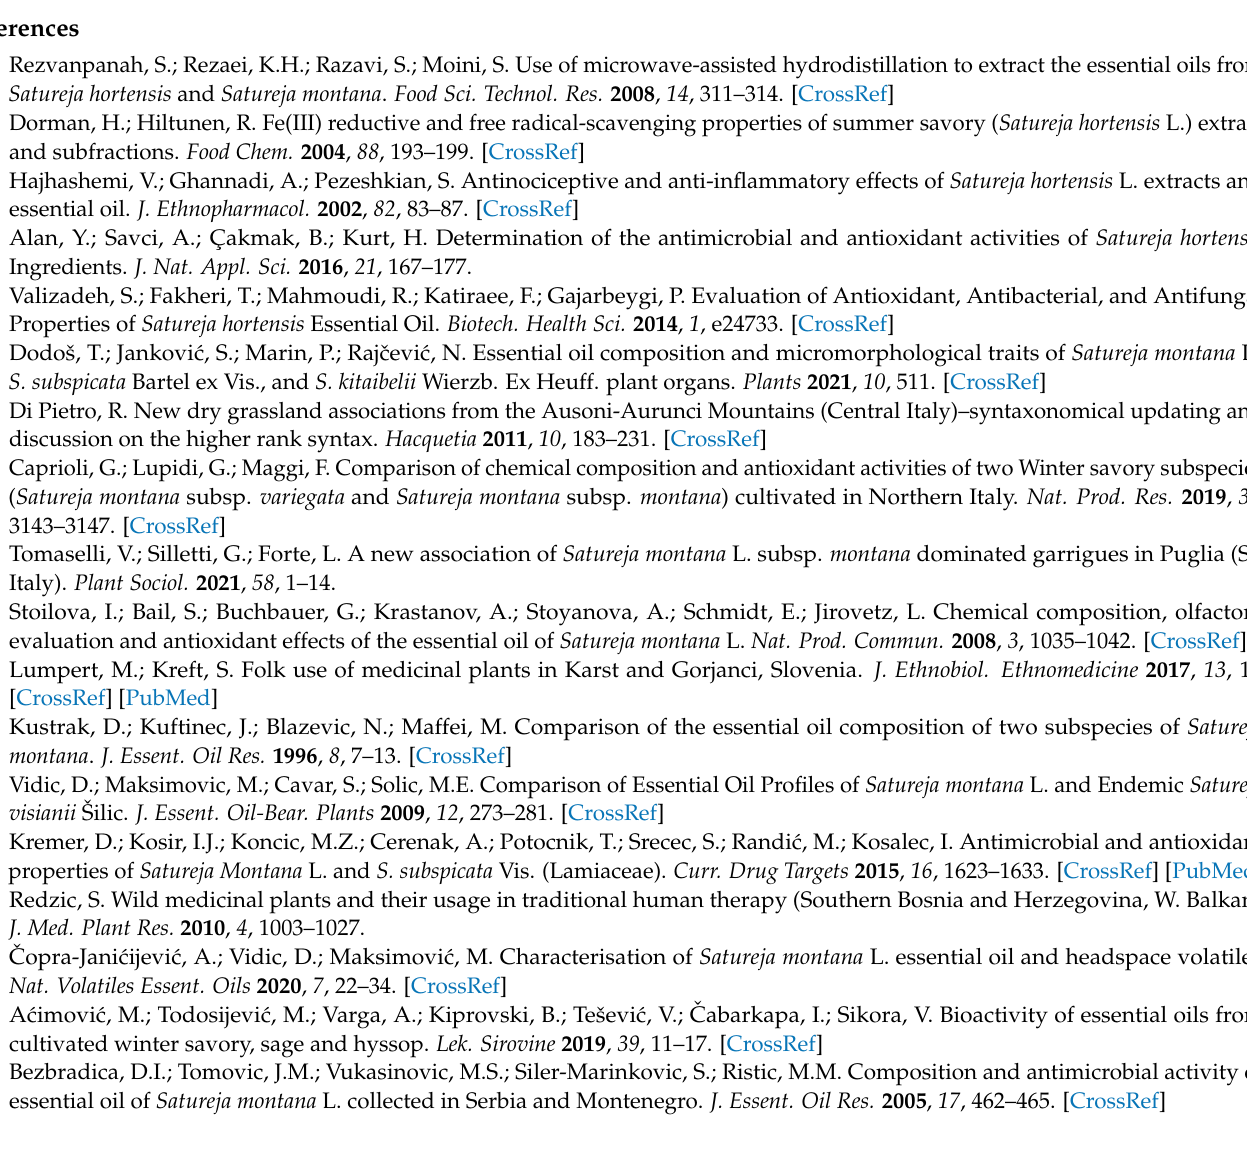
Table S2. The “goodness of fit” kinetics